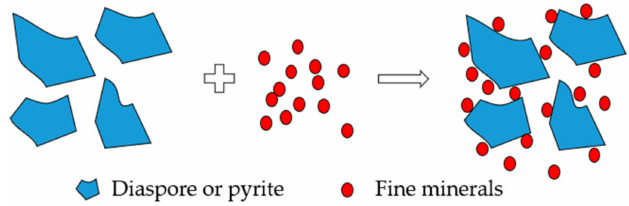
Figure 11. Schematic diagram of the mineral particle aggregation